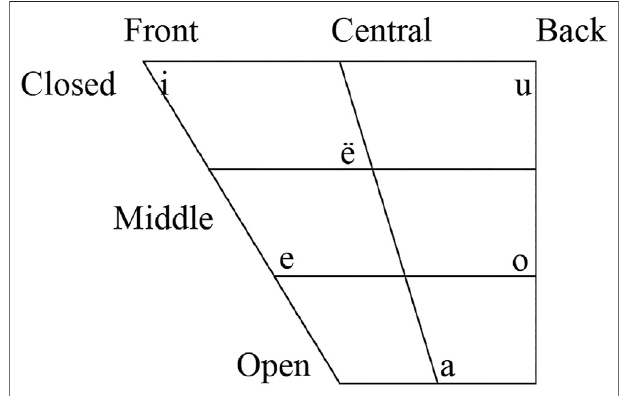
TABLE 6 | Cross-tabulation of stroke types and vowel positions.